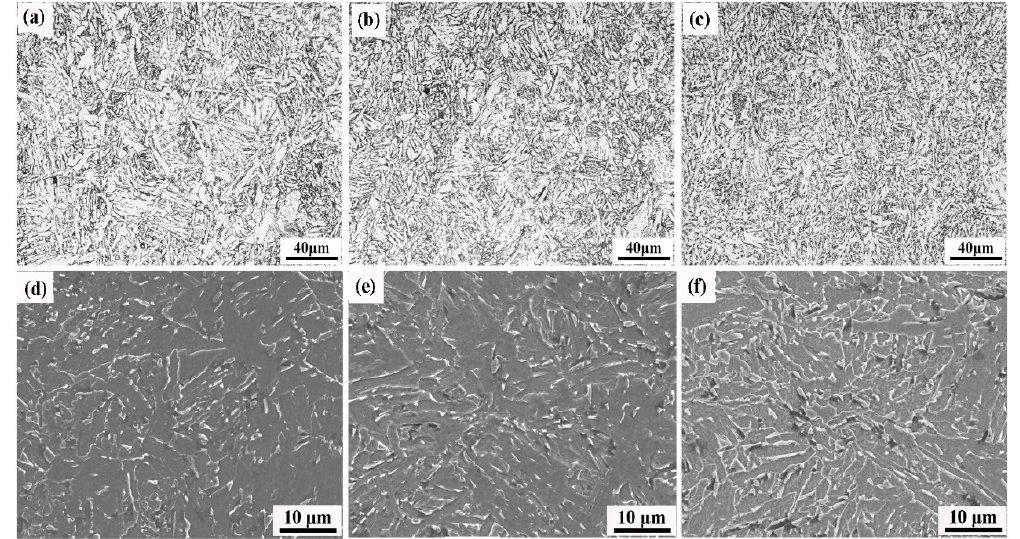
Figure 3. The microstructure of different cooling rate at the compression ratio of 0.35. ( a , d ) 10 °C/s; ( b , e ) 20°C/s; ( c , f ) 30 °C/s.